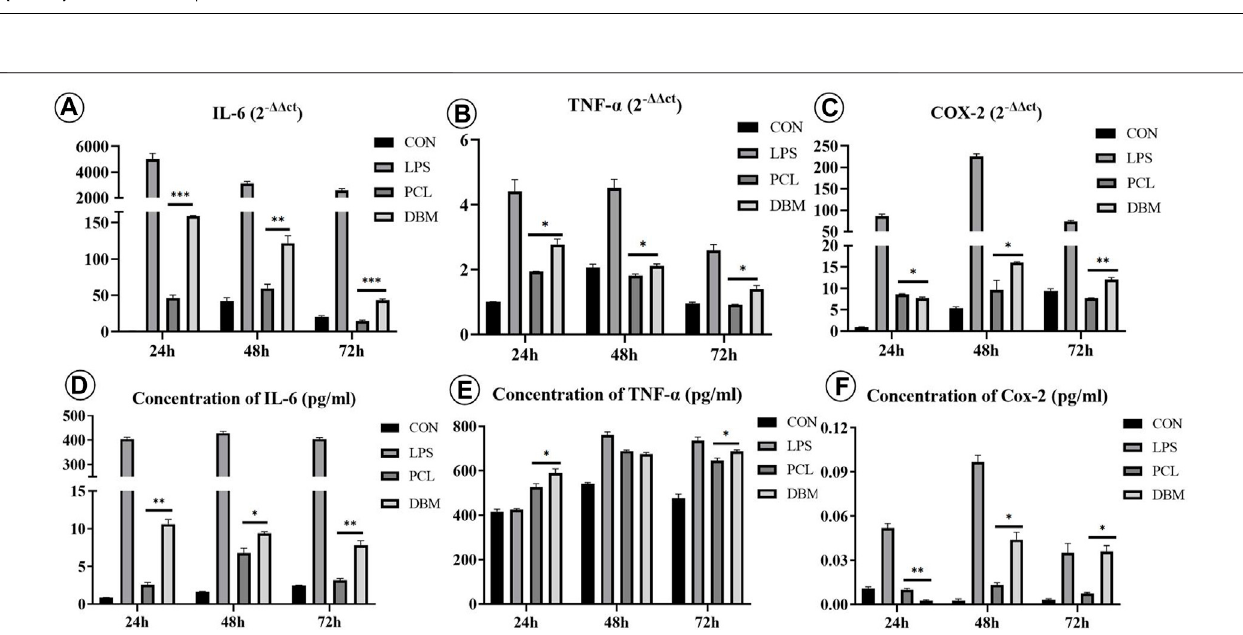
FIGURE 7 | Gene expression and cytokine secretion related to M1 polarization ofRAW 264.7 cells treated by leach solutions of PCL and DBM frameworks: (A – C) qPCR analysis of M1 polarization-related genes IL-6 (A) , TNF- α (B) , and COX-2 (C) ; (D – F) ELISA quanti fi cation of M1 polarization-related cytokines IL-6 (D) , TNF- α (E) , and COX-2 (F) . Statistical signi fi cance: *p < 0.05, **p < 0.01, ***p < 0.001.